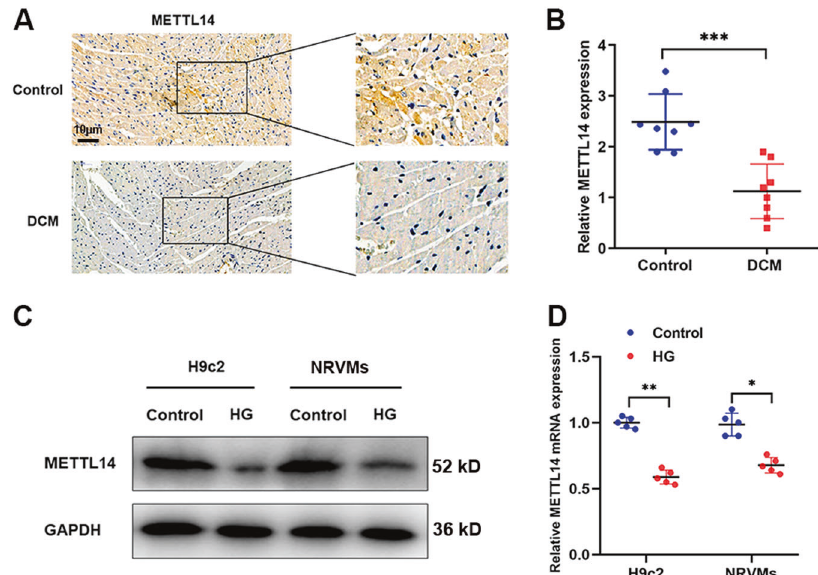
Fig. 3 METTL14 was downregulated in DCM rats. A METTL14 protein expression was detected in heart tissues of DCM and control rats. B Serum circulating METTL14 mRNA was determined in rats of respective groups, *** P < 0.001. C , D METTL14 protein ( C ) and mRNA ( D ) levels were detected in cardiomyocytes treated with HG, * P < 0.05, ** P <